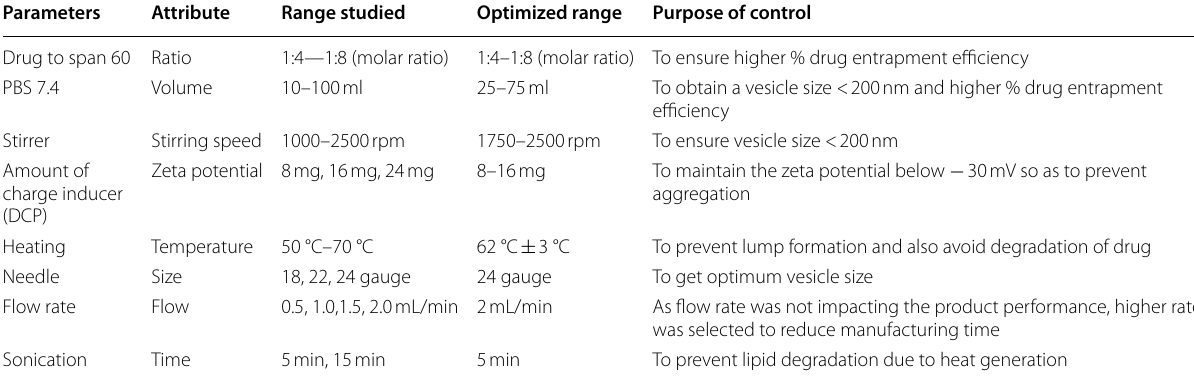
Table 6 Control strategies for the niosomal